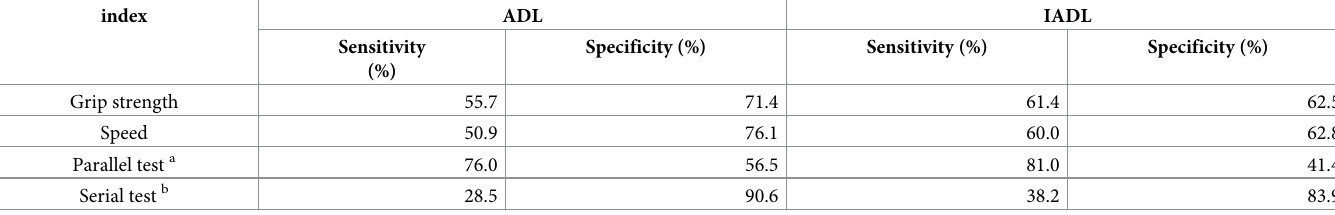
Table 4. Validity of physical performance measures alone and in combination for recognizing functional